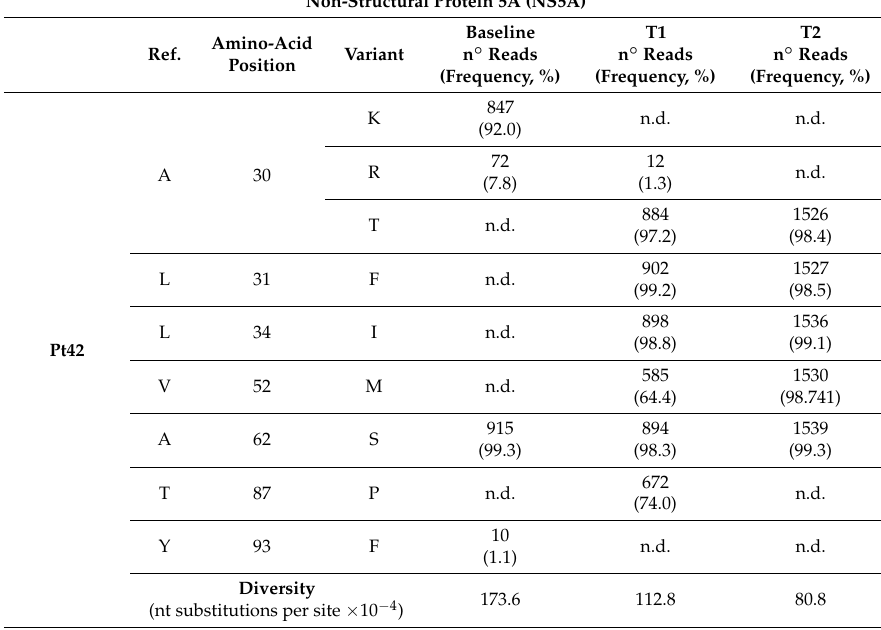
Table 4. Amino acid substitutions observed in NS5A and NS5B by ultra-deep pyrosequencing (UDPS) in patients who failed treatment. Only substitutions at positions involved in DAA resistance and/or showing relevant changes in frequency are reported. A threshold of 1% was applied. Only for those substitution that showed enrichment at virological failure lower baseline BL frequencies (i.e., 0.7%) were